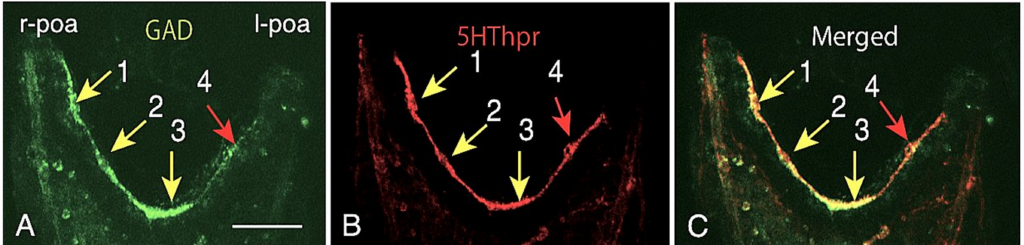
Figure 4. Heterogeneous expression intensities of cytoplasmic proteins among the post-oral-arm CBAS forming cells in 4aPL. ( A ) The intensity of GAD expression among the four cells is di ff erent; #3 cell expressed the most intensively, while #4 cell was the weakest, with the other two cells in between. ( B ) 5HThpr was expressed the most intensively in the #1 and #3 cells, while the other two cells were weaker. ( C ) Merged image between (A) and (B). Scale bar = 30 µ